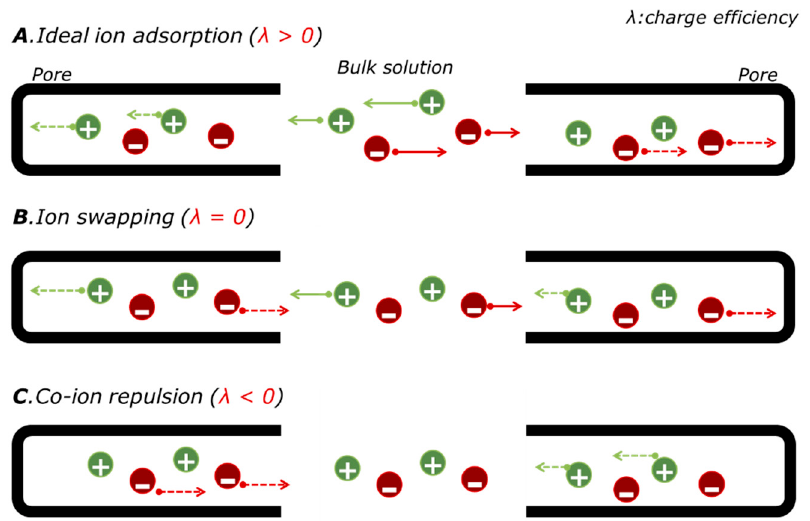
Figure 4. Ion removal mechanism of CDI with charge compensation on pores in the porous carbon electrode: ( A ) Ideal ion adsorption, ( B ) presence of the ion swapping, and ( C ) presence of the co-ion repulsion.